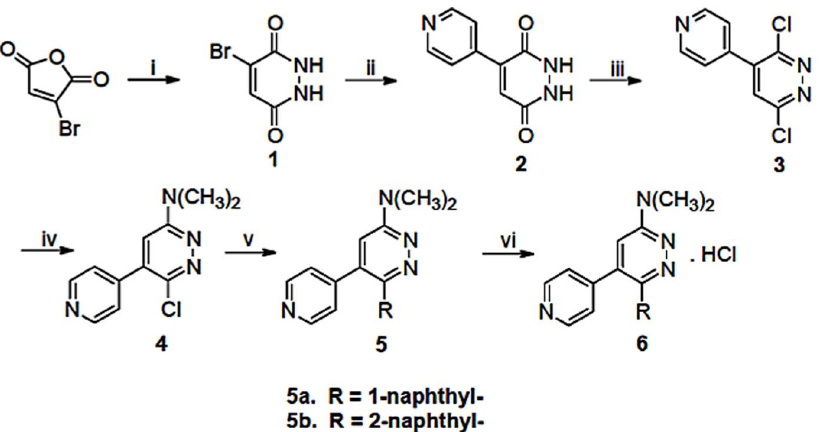
Figure 1. Discovery synthetic scheme for title compounds. Reagents and conditions: i) Hydrazine sulphate, H 2 O, 100 u C; ii) Pyridin-4-ylboronic acid; 1,2-dimethoxyethane (DME)/water, Na 2 CO 3 , Pd(PPh 3 ) 4 , 110 u C; iii) phosphorus oxychloride/acetonitrile, 90 u C; iv) Ethanol, amine, reflux; v) 1- or 2- Naphthylboronic acid, DME/water, Na 2 CO 3 , Pd(PPh 3 ) 4 , 110 u C; vi) concentrated HCl, anhydrous isopropanol, 80 u C.